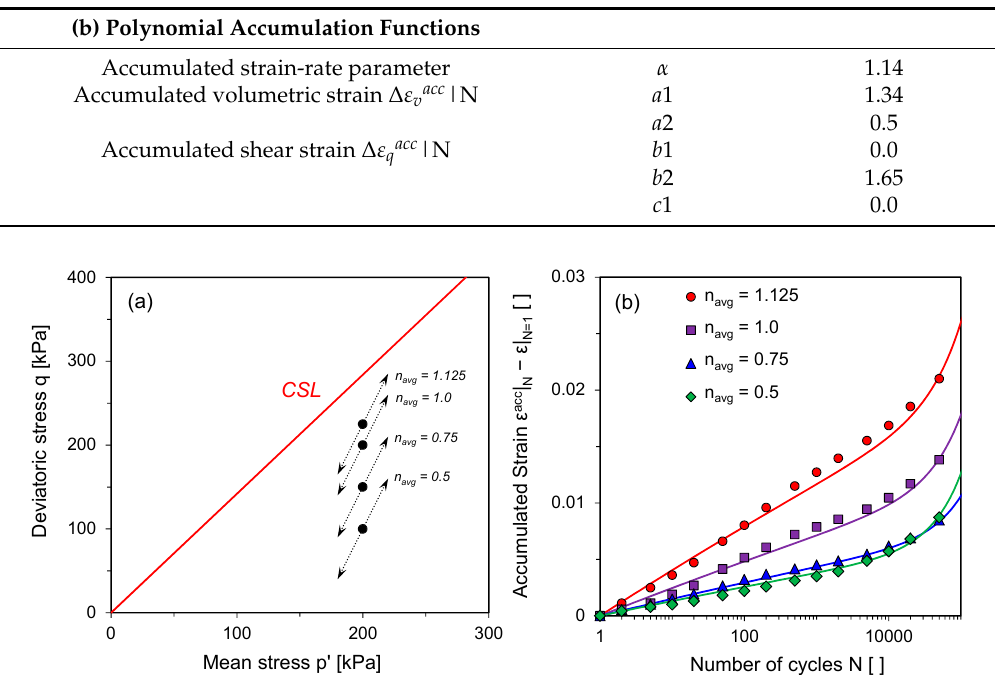
Figure 4. Model calibration using drained cyclic triaxial test results. ( a ) Stress path with four different average stress obliquities n avg —average mean stress is p’ avg = 200 kPa and cyclic stress amplitude is Δ q = 60 kPa; and ( b ) accumulated strain defined with ε acc = [( ε axial ) 2 + 2( ε radial ) 2 ] 0.5 [23].